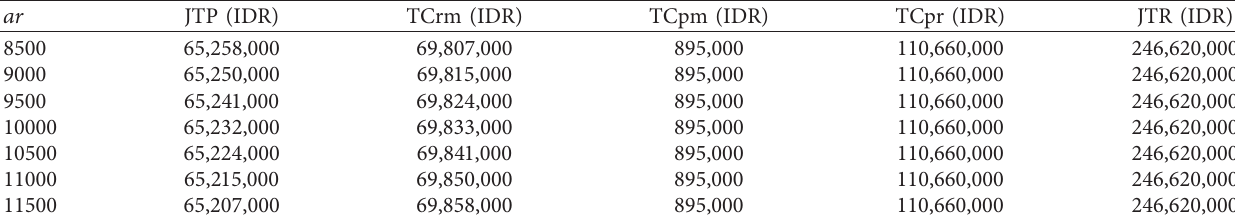
Table 7: Analysis of sensitivity to the effect of ar on cost, revenue, and